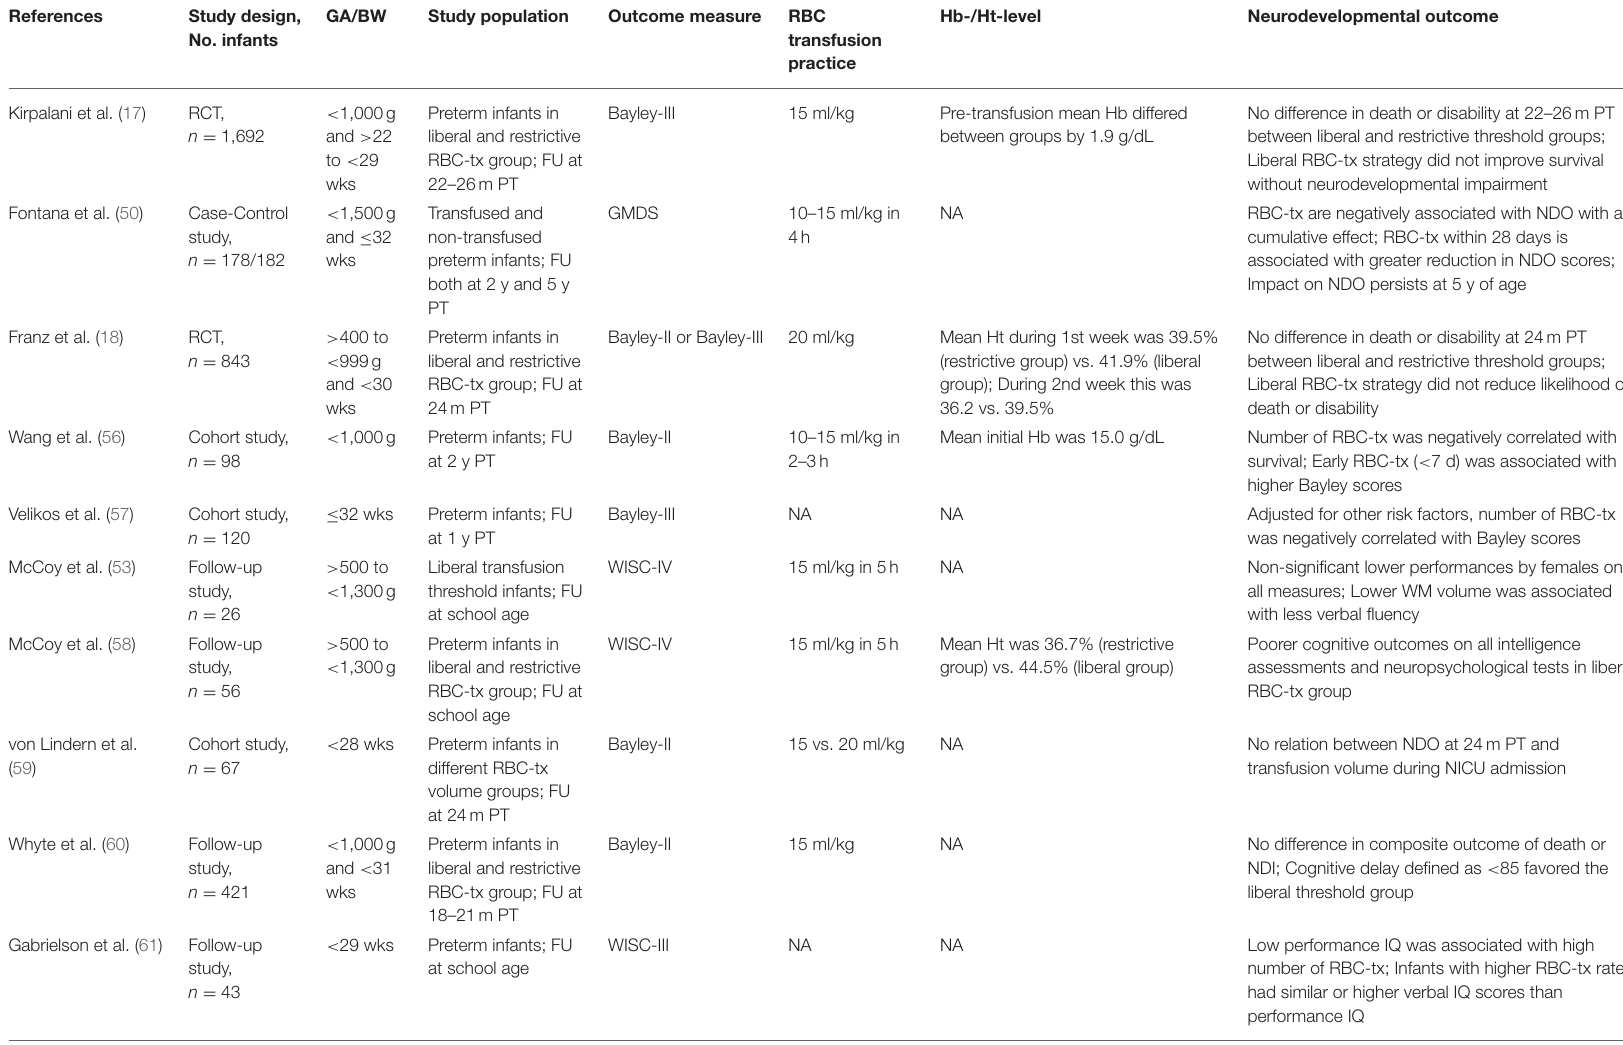
TABLE 3 | Results of selected studies on neurodevelopmental